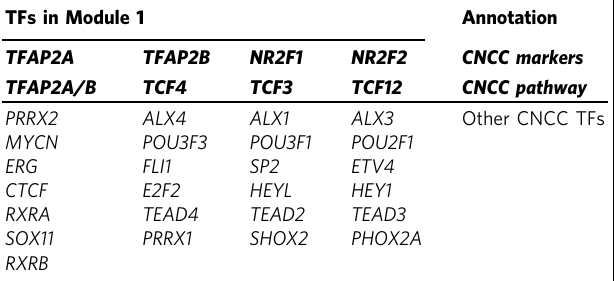
Table 1 TFs in Module 1 are annotated as CNCC markers, pathways and other CNCC